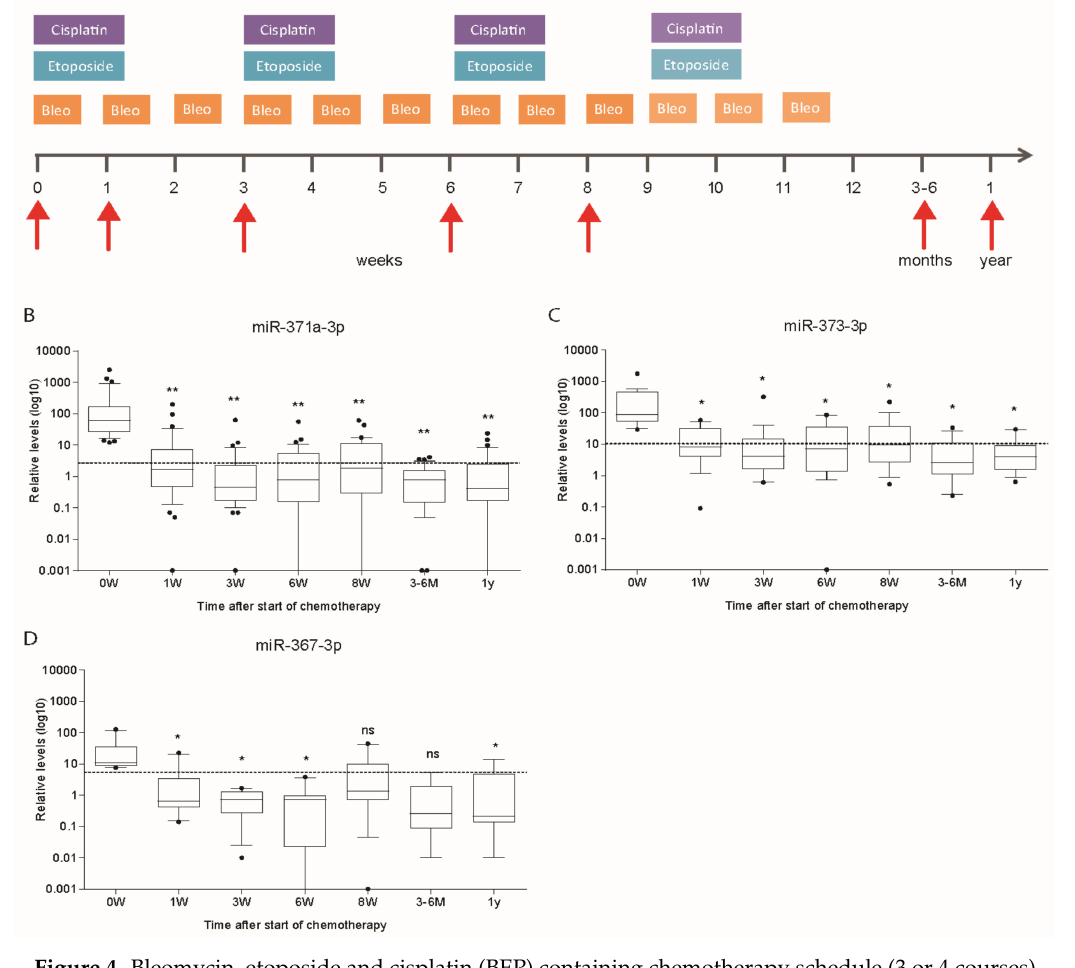
Figure 4. Bleomycin, etoposide and cisplatin (BEP) containing chemotherapy schedule (3 or 4 courses) as well as sampling time points (red arrows) of cohort 1 ( A ). Follow-up of relative level of miR-371a-3p ( n = 39) ( B ), miR-373-3p ( n = 19) ( C ) and miR-367-3p ( n = 10) ( D ) after start of chemotherapy. Patients with relative miR levels above the described threshold at start of treatment are depicted. Repeated measures ANOVA was used to test significance (* p < 0.05, ** p <